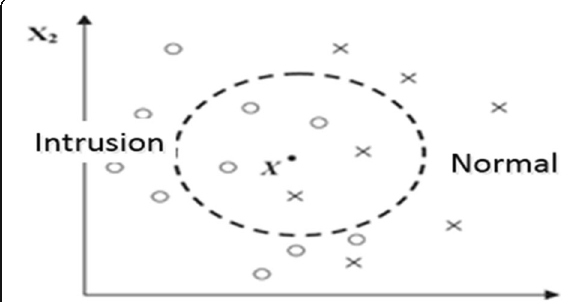
Fig. 6 An example of classification by k-Nearest Neighbour for k =